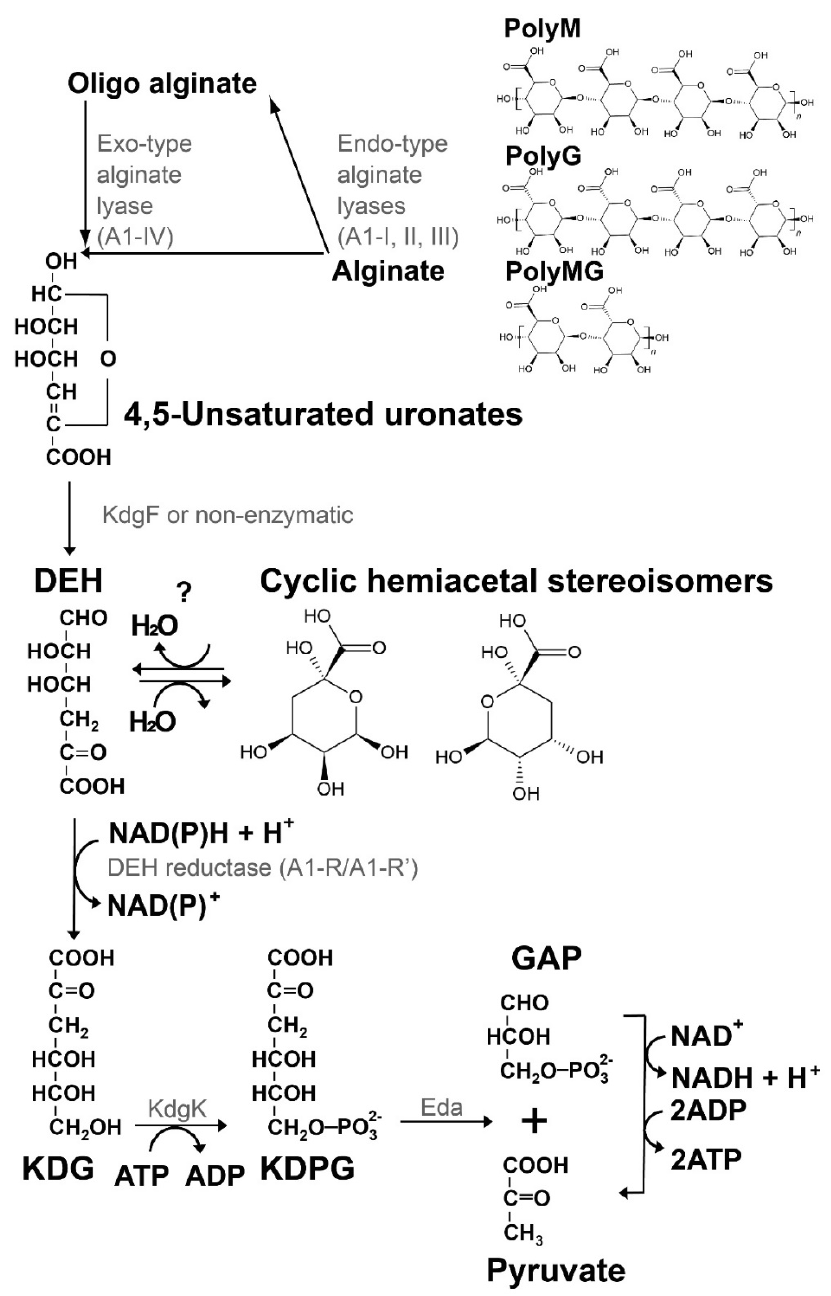
Figure 1. Pathway for alginate metabolism